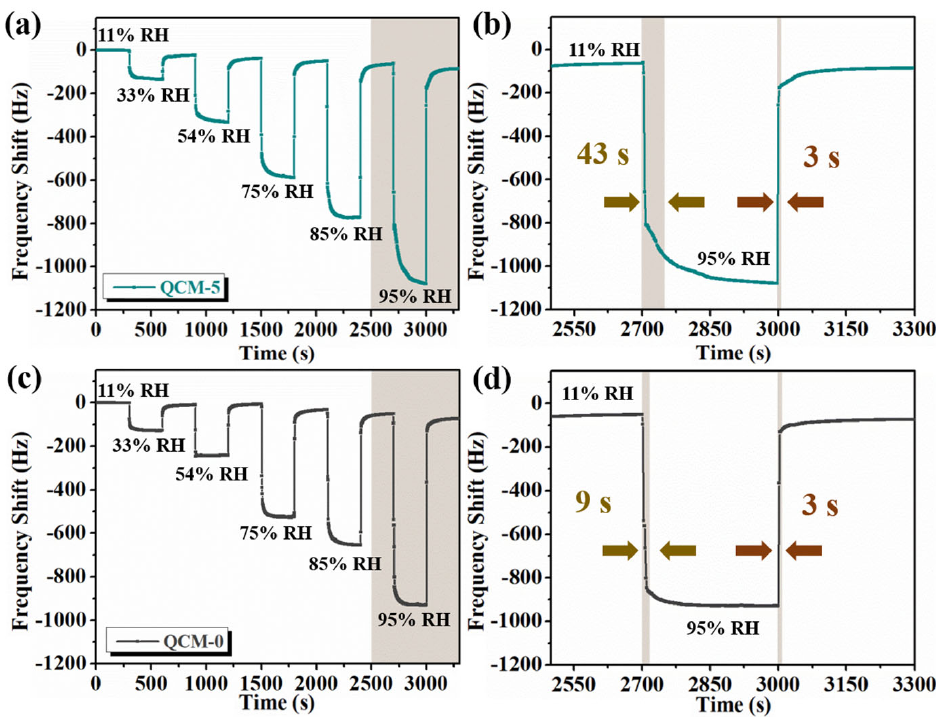
Figure 5. The repeatability response curves of ( a ) QCM − 5 and ( c ) QCM − 0, ( b , d ) are the enlarged images of the shaded part of ( a , c ), respectively.